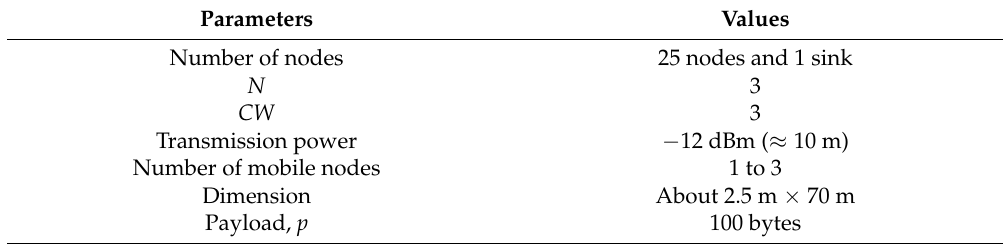
Figure 13. Tree network topology with the traces of mobile nodes for both simulation and experiment (H = 6, average speed of 1 m per second, and pause time of 5 s at each stop). Table 6. Key experimental parameters and values for experiment.